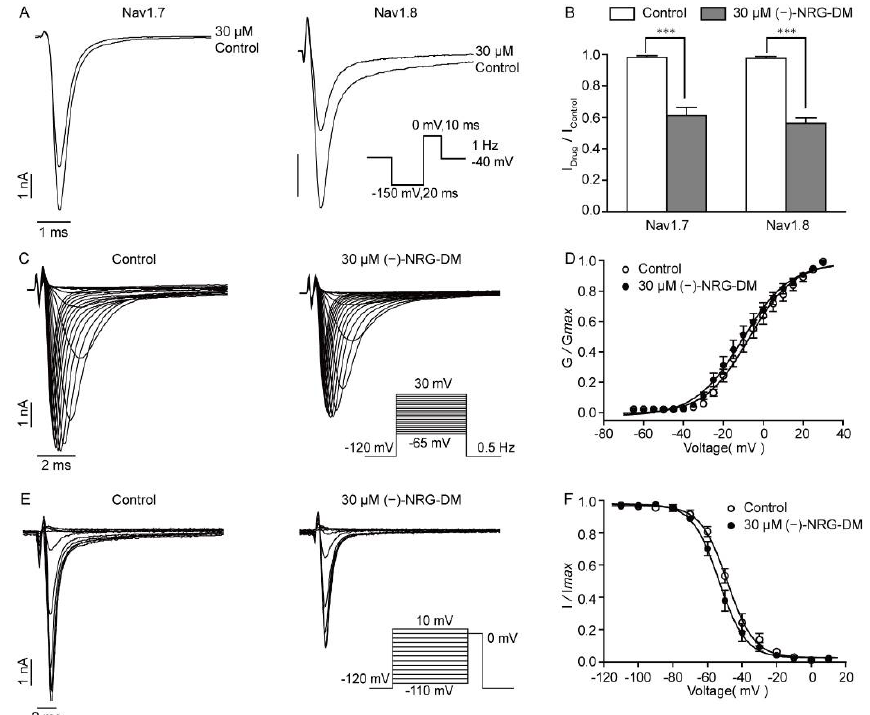
Figure 8 . Inhibitory effect of (−)-NRG-DM on Nav currents. ( A ) Representative Nav1.7 and Nav1.8 current traces in the absence and presence of 30 μM (−)-NRG-DM recorded with the depicted protocol. ( B ) Summarized data showing the suppression effect of (−)-NRG-DM (30 μM) on Nav1.7 and Nav1.8 channels ( n = 5). ( C ) Representative Nav1.8 current traces in absence and presence of 30 μM (−)-NRG-DM recorded with the protocol shown inset. ( D ) Activation curves obtained in the absence and presence of 30 μM (−)-NRG-DM ( n = 13). ( E ) Representative activation current traces of Nav1.8 currents before and after 30 μM (−)-NRG-DM. ( F ) Steady-state inactivation curve of Nav1.8 currents before and after 30 μM (−)-NRG-DM ( n = 13). Statistical significance: *** p ≤ 0.001.